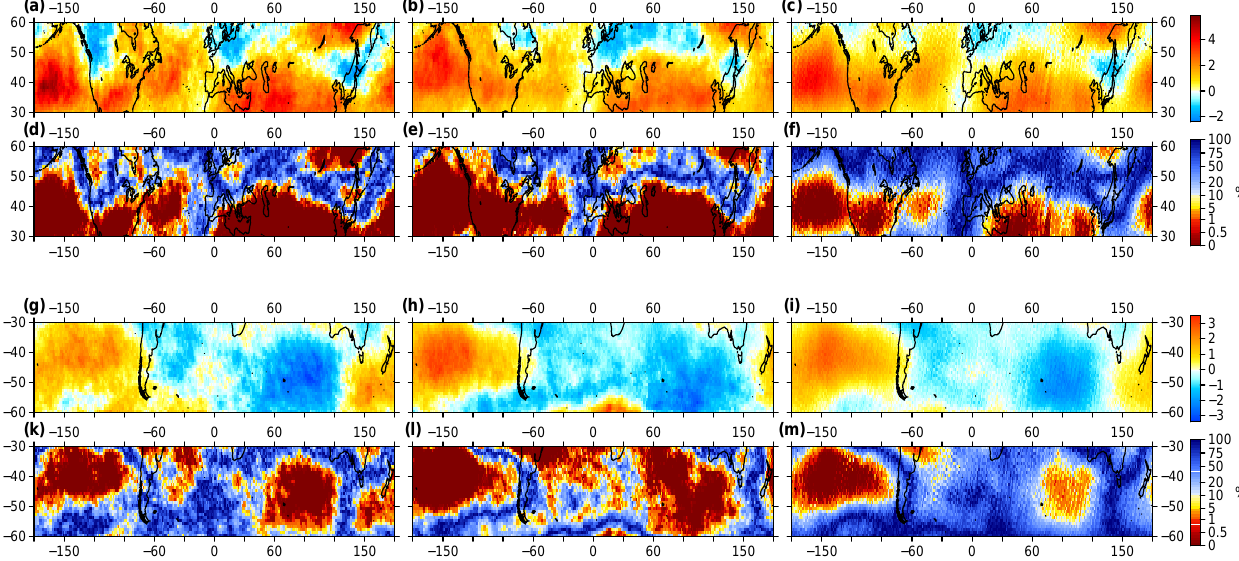
Fig. 1. Pointwise regression coefficient estimates (in DU ( unitENSO ) − 1 ) for the El Ni˜no/Southern Oscillation on an annual basis for (a) EHOs, (b) ELOs, and (c) mean values of total ozone at 30 ◦ N to 60 ◦ N; (d) – (f) show the p -values of pointwise significance tests for the estimates in (a) – (c) . (g) – (m) as (a) – (f) but at 30 ◦ S to 60 ◦ S. An augmented version of this figure including standard errors for all coefficient estimates is provided in Fig.